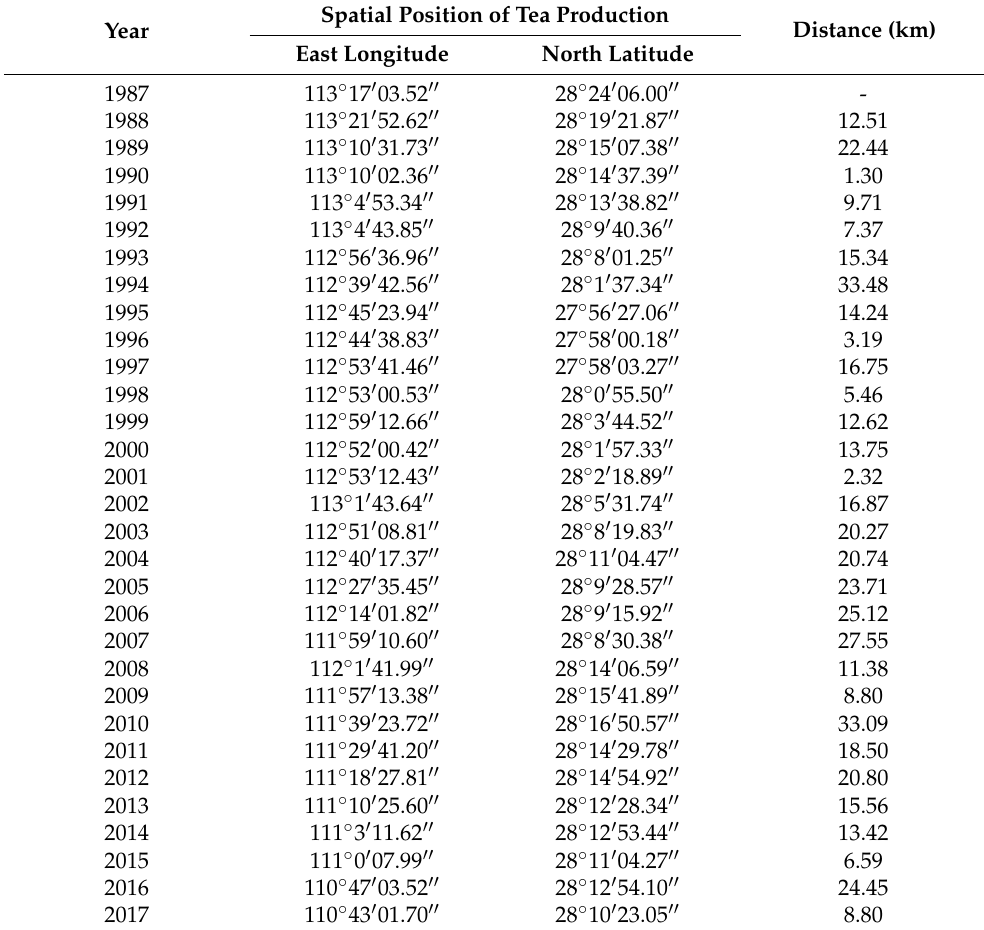
Figure A2. Variation of Tea Production Cities in Shandong Province. The red and blue points are the locations of recorded tea producing cities in 1987 and 2017 according to the statistical data, respectively. Table A2. Moving Distance of Tea Production Gravity Center in China from 1987 to 2017.